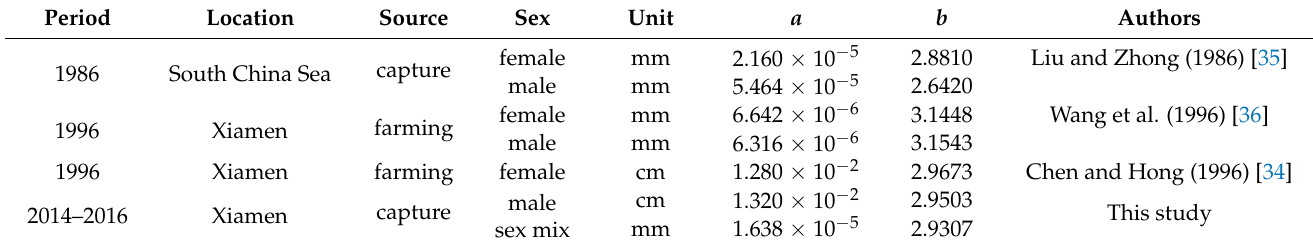
Table 1. Comparison of the relationship between body length and weight of P. penicillatus